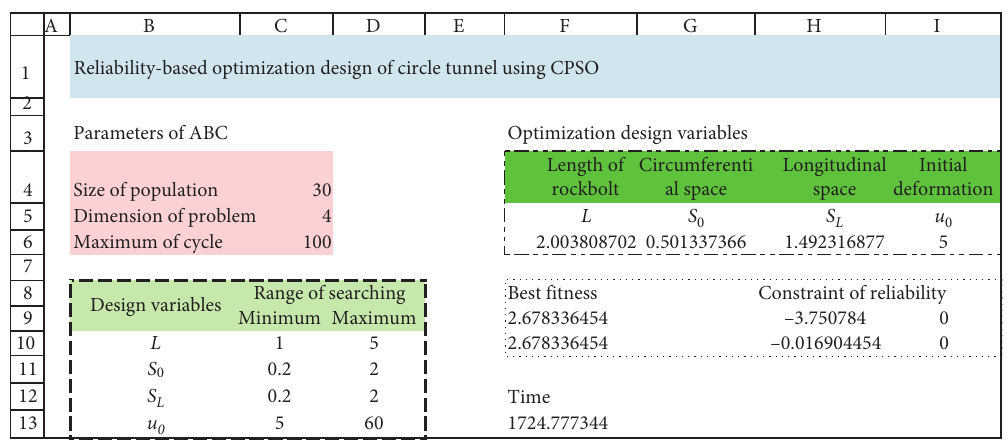
Figure 6: Reliability-based support optimization design of the tunnel using CPSO.